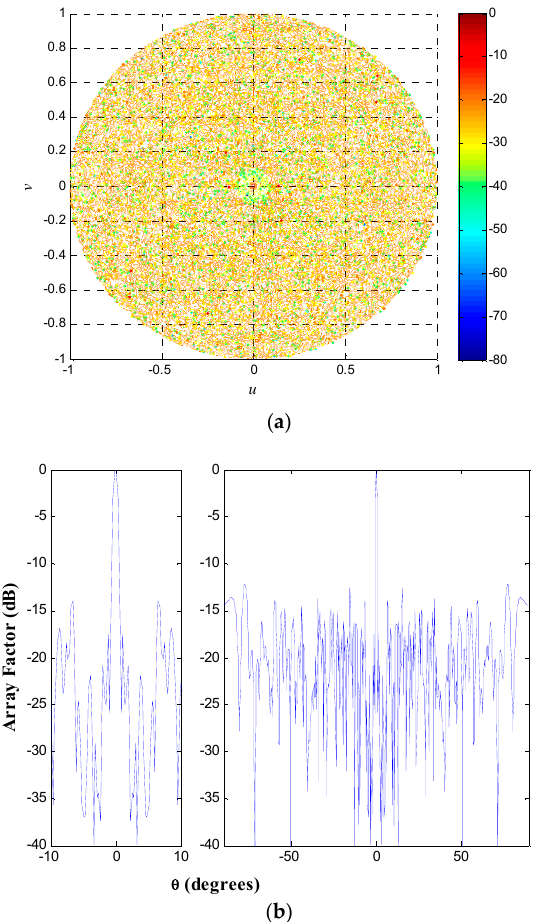
Figure 9. (a ) Array factor and ( b ) cut of the array factor at φ = 0 ° for the antenna array configuration illustrated in Figure 8.